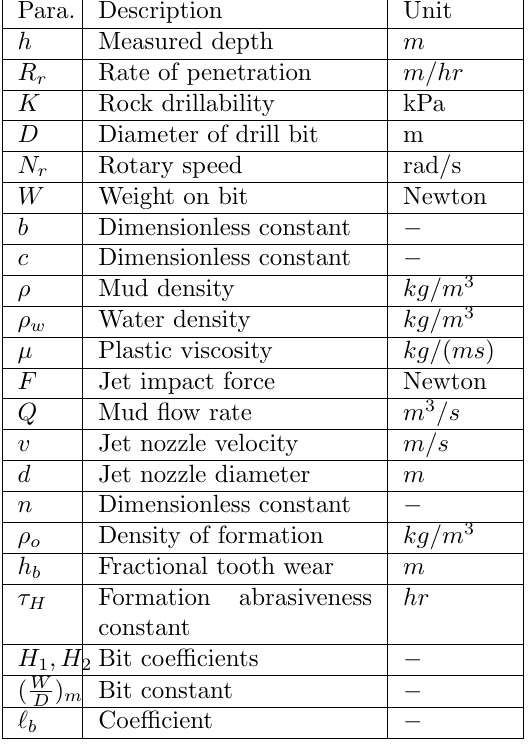
Table 1: Model parameters in Section